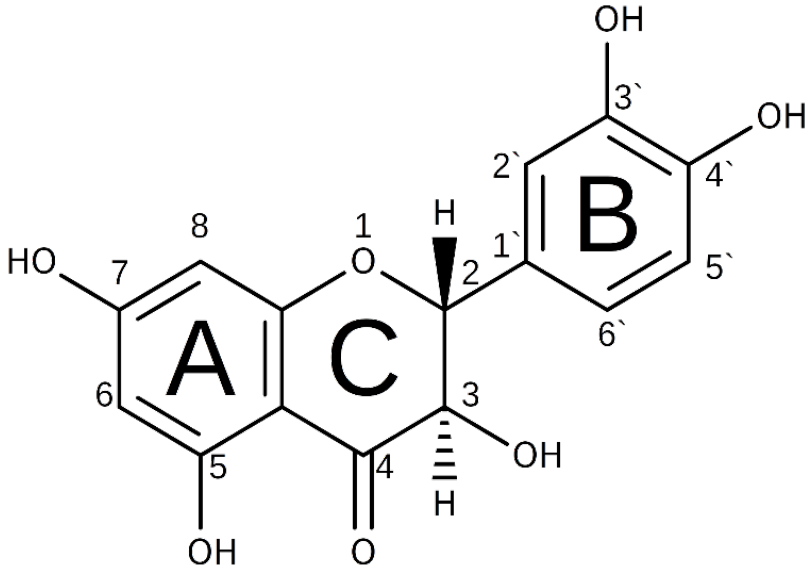
Figure 1. Chemical structure of 2 R ,3 R -DHQ.